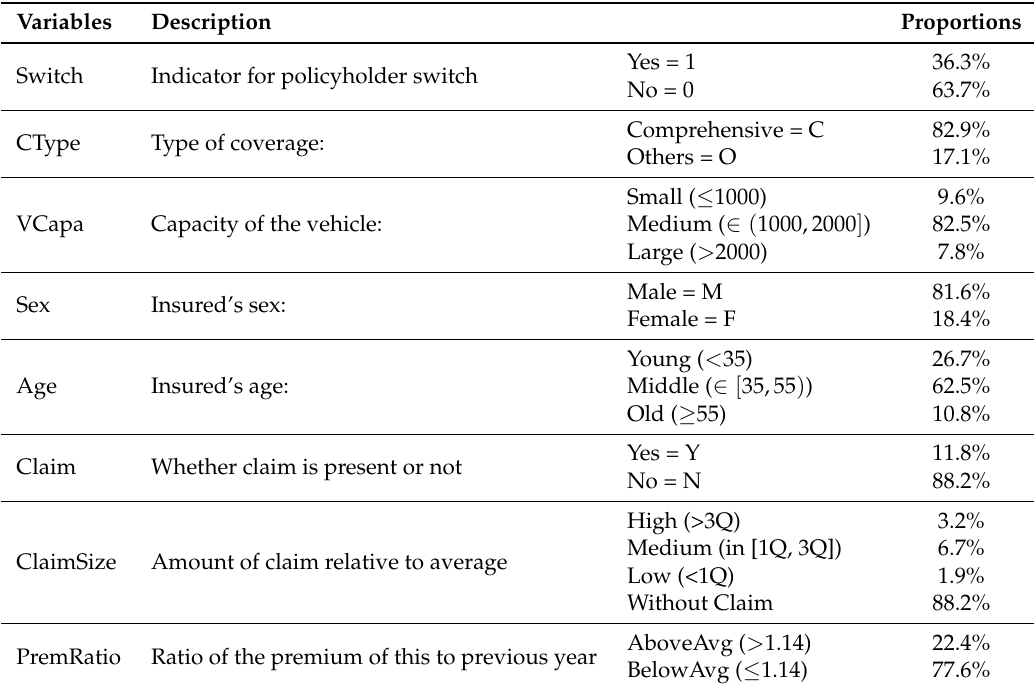
Table 3. Description of variables and summary